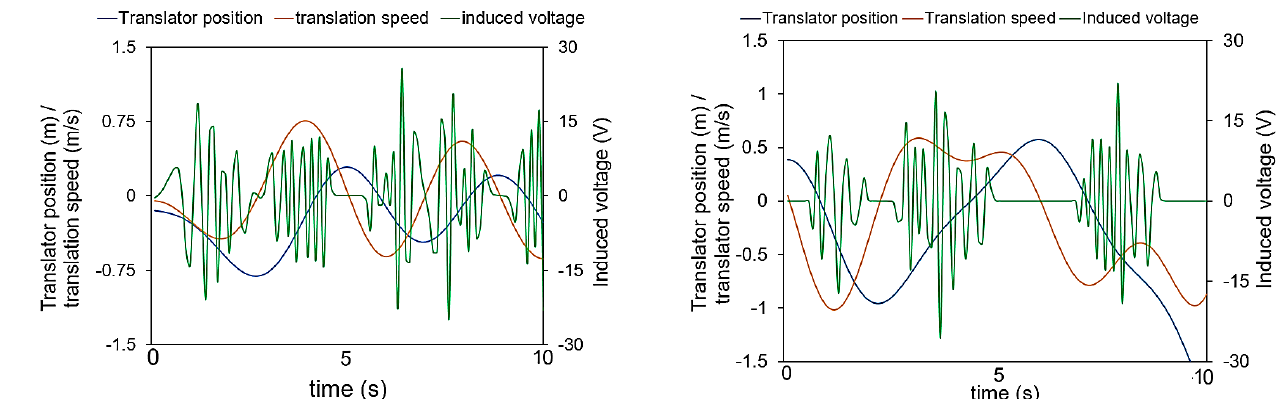
Figure 17. The graphs of the induced voltage of ( a ) iron-cored LPMG and ( b ) semi iron-cored LPMG from calculation and experiment; ( c ) induced voltage of LPMG designs under the regular wave.